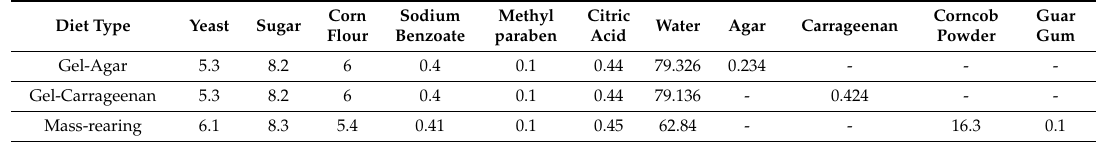
Table A3. Diet formulations tested in Experiment 3; each diet treatment was replicated 16 times. The values of diet ingredients are given as percentages ( w / w